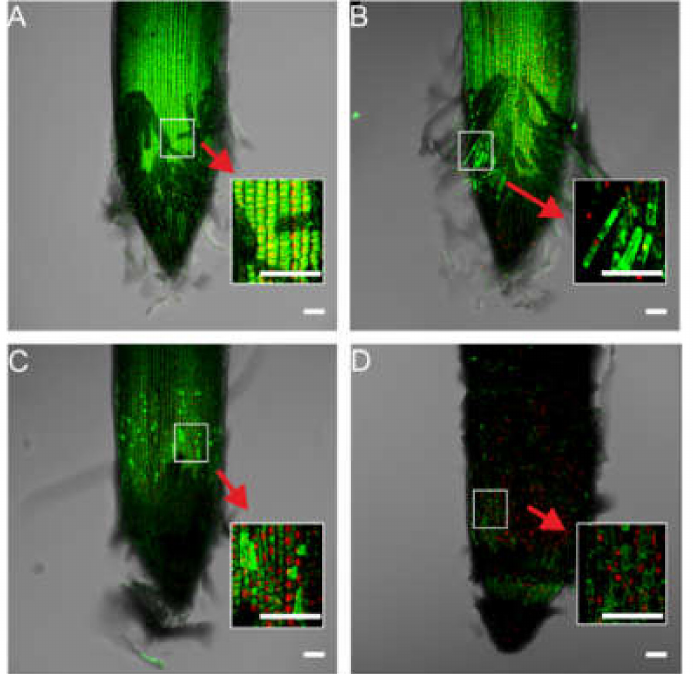
Figure 5. Fluorescence images of a live/dead assay of the wheat root tips after 3 days of seedling development in (Bio)Ag NPs at 0 ( A ), 10 ( B ), 20 ( C ), and 40 ( D ) mg/L. Syto9 green fluorescence is characteristic for viable cells and nonviable cells, and PI red fluorescence is characteristic for nonviable cells only (red arrows show enlarged pictures). Scale: the length of the horizontal white bars equals 100 µ